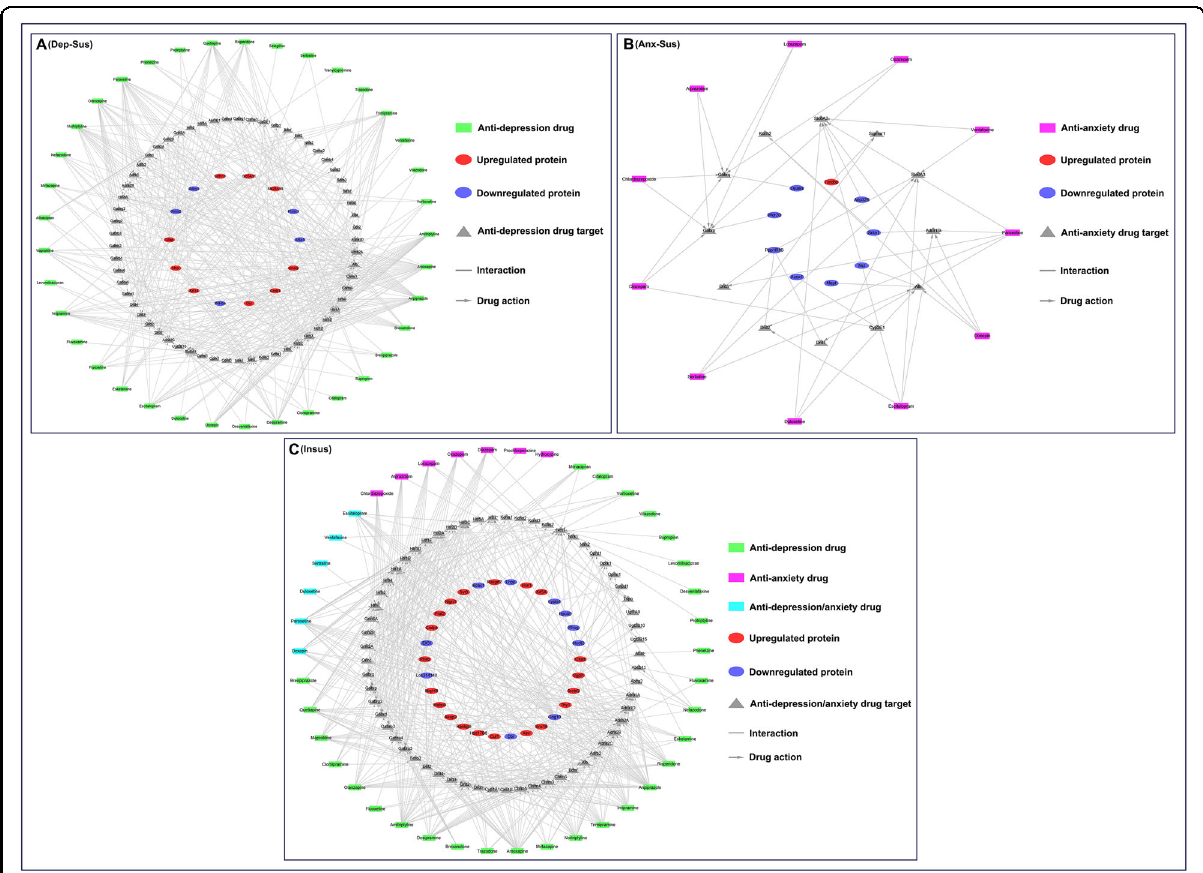
Fig. 4 Analysis of phenotype-target-drug networks. The networks from the depression-susceptible (Dep-Sus, A ), anxiety-susceptible (Anx-Sus, B ), and insusceptible (Insus, C ) groups were built by the Search Tool for the Retrieval of Interacting Genes/Proteins (STRING) and